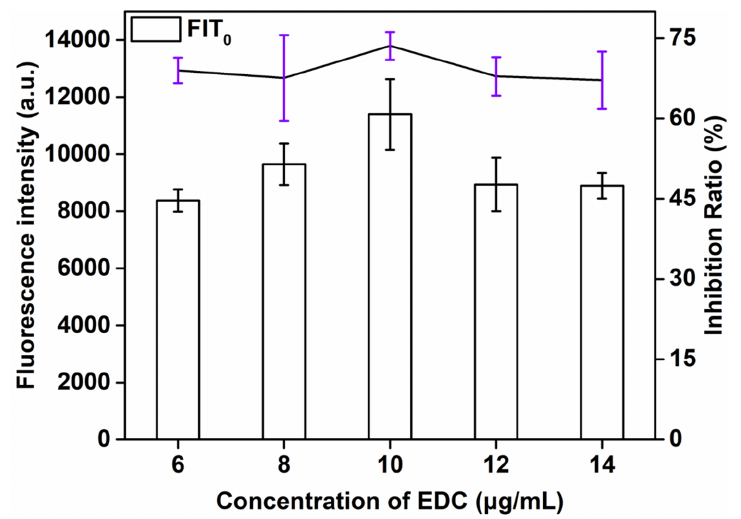
Figure 3. Optimization detection conditions of QBs-LFIA. Effects of concentration of EDC.